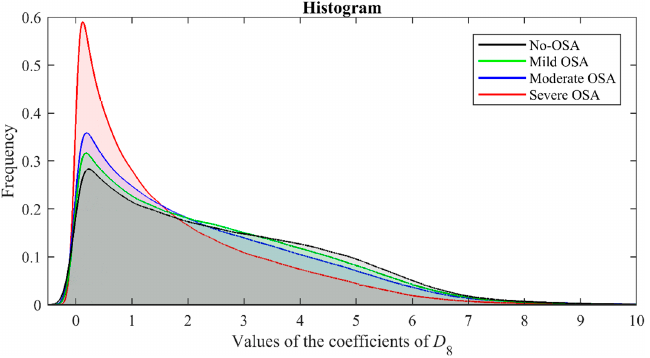
Figure 5. Distribution of the coefficients of D 8 by OSA severity in the training group. Table 2. Statistical analysis of the extracted features in the training group. Feature